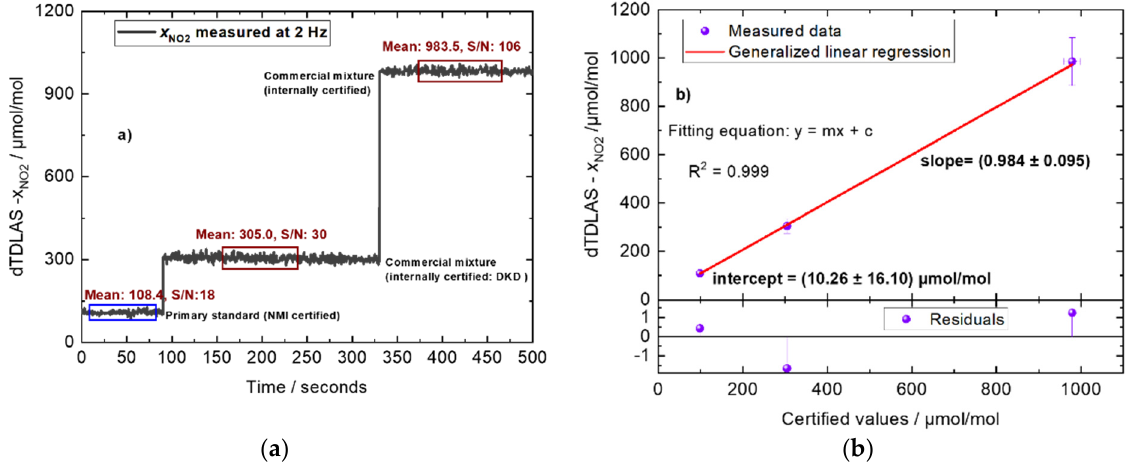
Figure 4. ( a ) Plot of the NO 2 OGS amount fraction results at different levels as a function of time (at ∆ t = 86 s, 1 σ for 108.4, 305.0 and 983.5 are 6.2, 9.9 and 9.6, respectively); ( b ) dTDLAS NO 2 amount fraction x NO2 results as a function-certified values of gas mixtures.